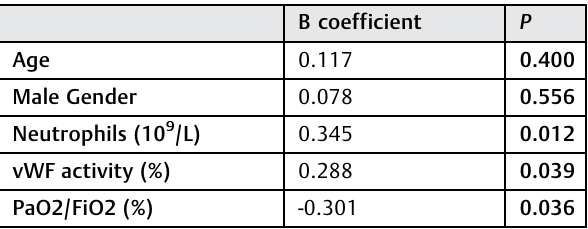
Table 4 In fl uence of the predictive variables for mortality, after adjustment by age, gender, by multivariable linear regression analysis